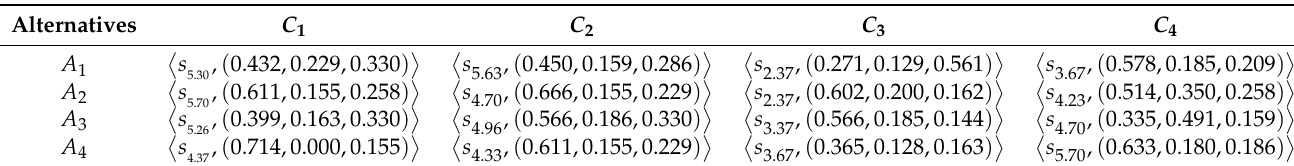
Table 7. Collective SVNL decision matrix R .